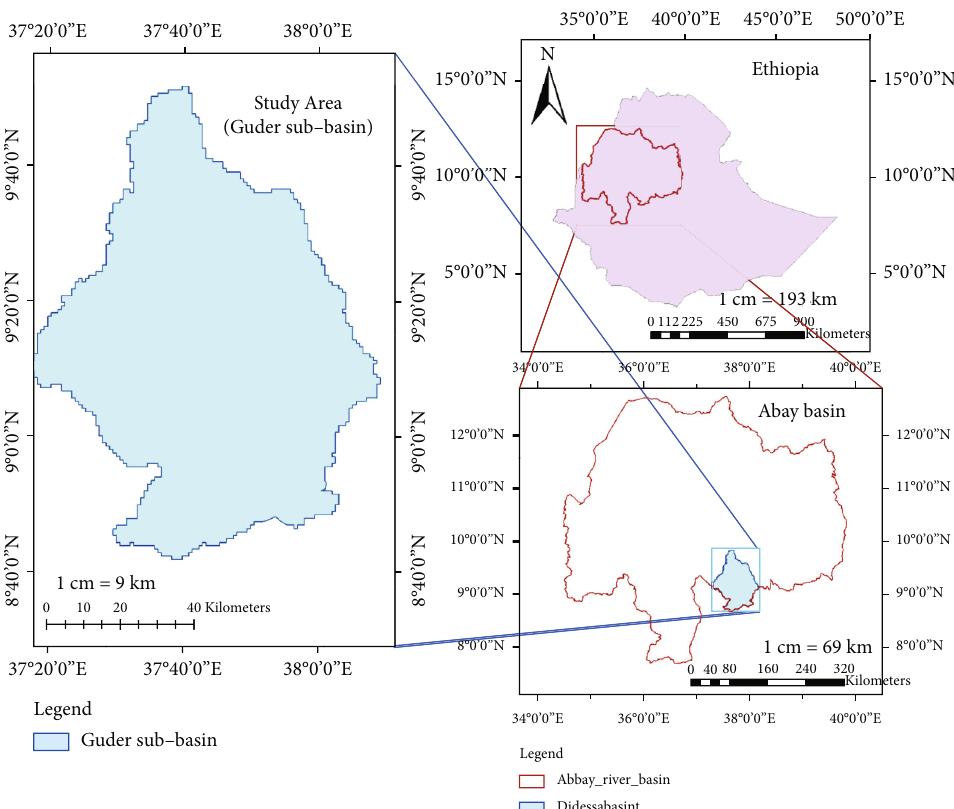
Figure 1: Geographical location of the study